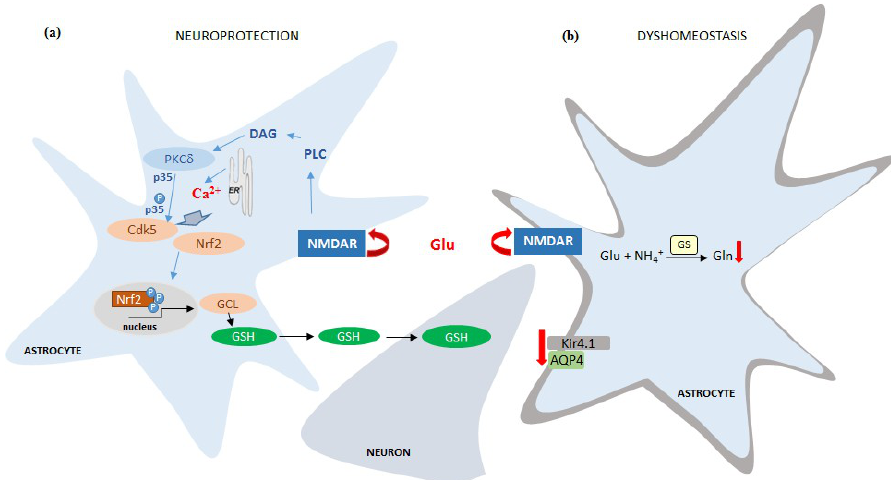
Figure 3. Schematic description of mechanisms by which NMDAR activation in astrocytes leads either to neuronal protection ( a ) or to deregulation of astrocytic proteins critical for their functions ( b ). ( a ) Activation of NMDAR on astrocytes leads to PLC activation triggering the release of Ca 2+ from the ER. PLC activate PKC δ , likely through diacylglicerol (DAG), leading to p35 phosphorylation, and cyclin-dependent kinase-5 (Cdk5) activation; p35/Cdk5 complex phosphorylates Nrf2 and promotes Nrf2 translocation to the nucleus, inducing the expression of different antioxidant genes, including glutamate-cysteine ligase (GCL), the rate-limiting enzyme of glutathione (GSH) biosynthesis. The increase of GSH synthesis and release supports neurons against ROS-mediated oxidative damage [48]. ( b ) Activation of NMDAR on astrocytes leads to loss of astrocytic proteins critical for their housekeeping functions, namely glutamine synthetase (GS), the water channel protein aquaporin-4 (AQP4), and the inward rectifying potassium channel Kir4.1.